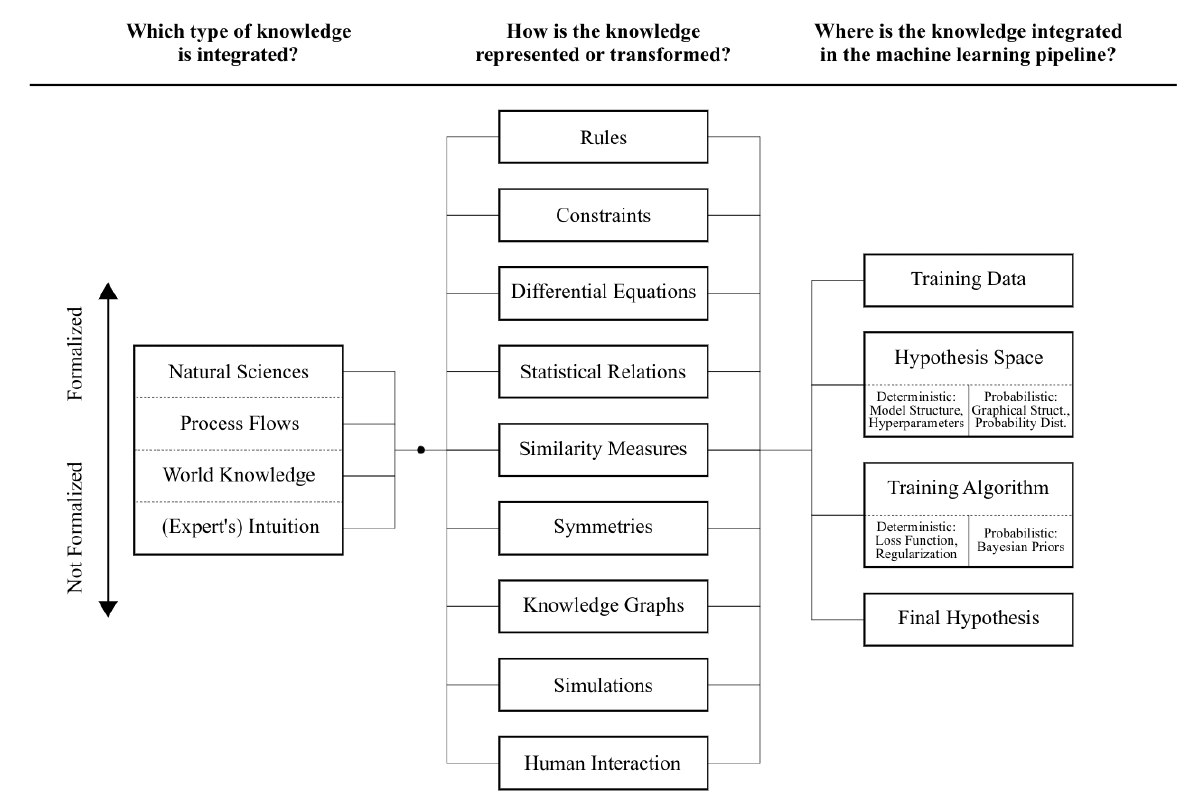
Figure 5. Knowledge source, its formalization and application to different ML/DM stages [8]. Table 2. Sensing platforms in Industrial